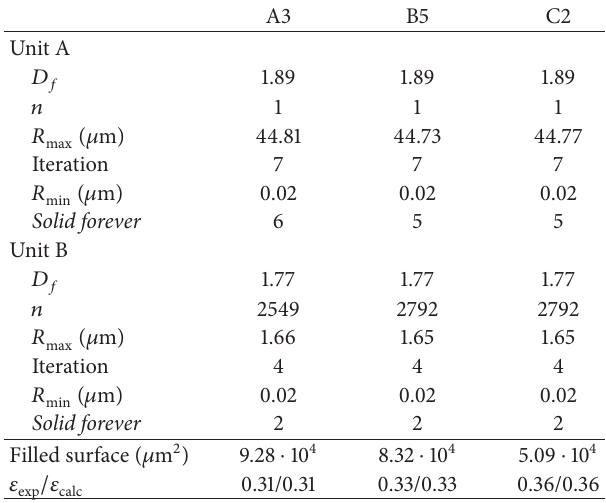
Table 2: IFU model input data for reproducing pore size distribu- tion of samples A3, B5, and